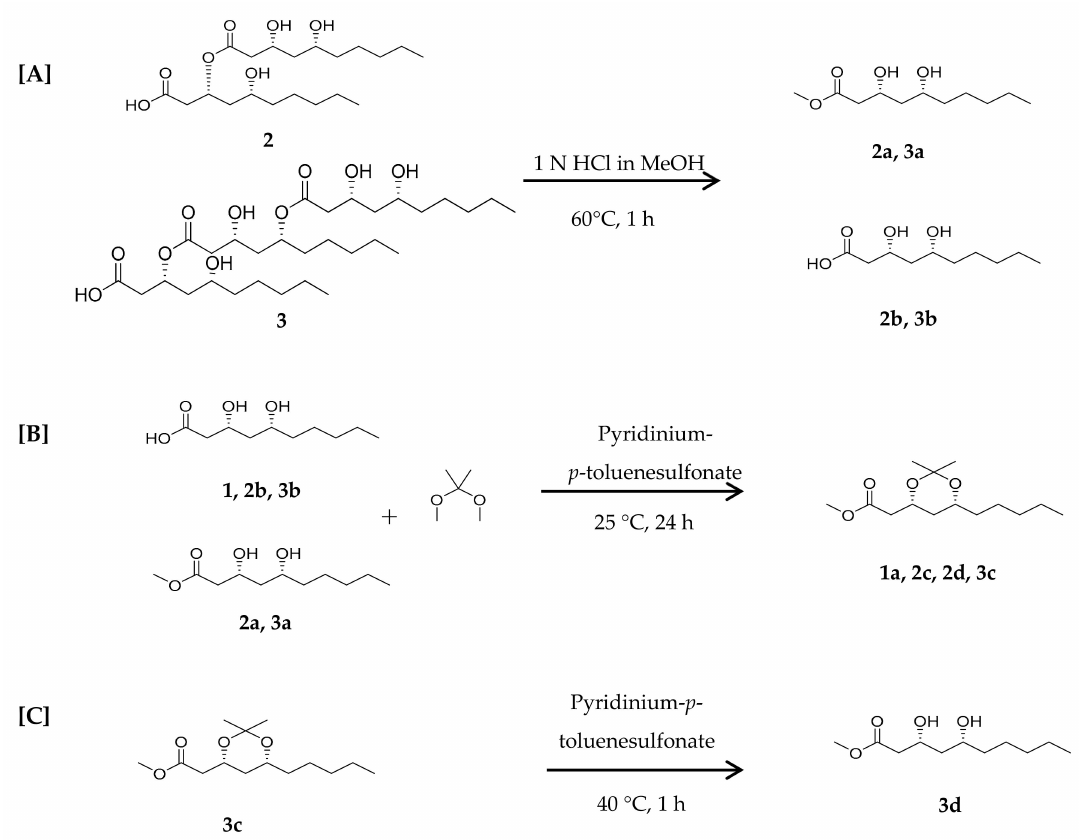
Figure 3. Reaction procedures for elucidation of stereochemistry for compounds 1 – 3 ; ( A ) hydrolysis of compounds 2 and 3 ; ( B ) synthesis of 1,3-diol-acetonides for 1 , 2b , 3b , 2a , and 3a ; and ( C ) deprotection of acetonide for 3c